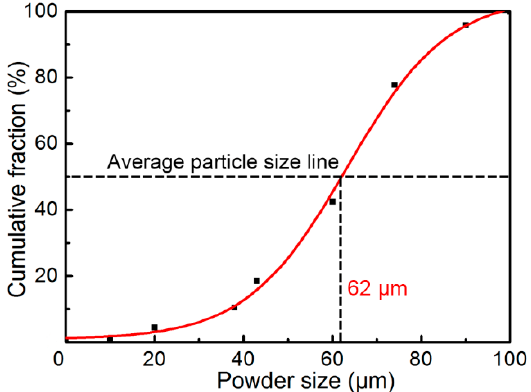
Figure 2. Distribution of powder sizes of gas-atomized Cu (60.9 wt.%)/Sn alloy.